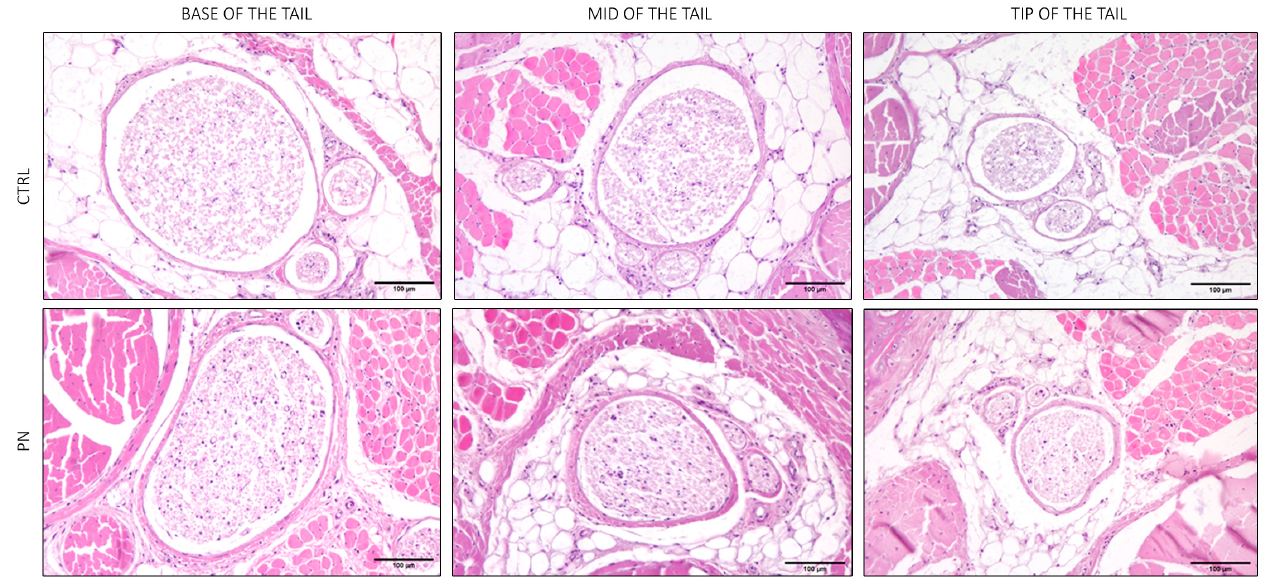
Figure 4. Light microscopy of significant sections of the whole tail (haematoxylin and eosin). In the upper panel, representative images from control (CTRL) animals, and in the bottom panel representative images of the peripheral neuropathy (PN) animals are shown. CTRL: control group; PN: peripheral neuropathy group. Scale bars represent 100 µm.